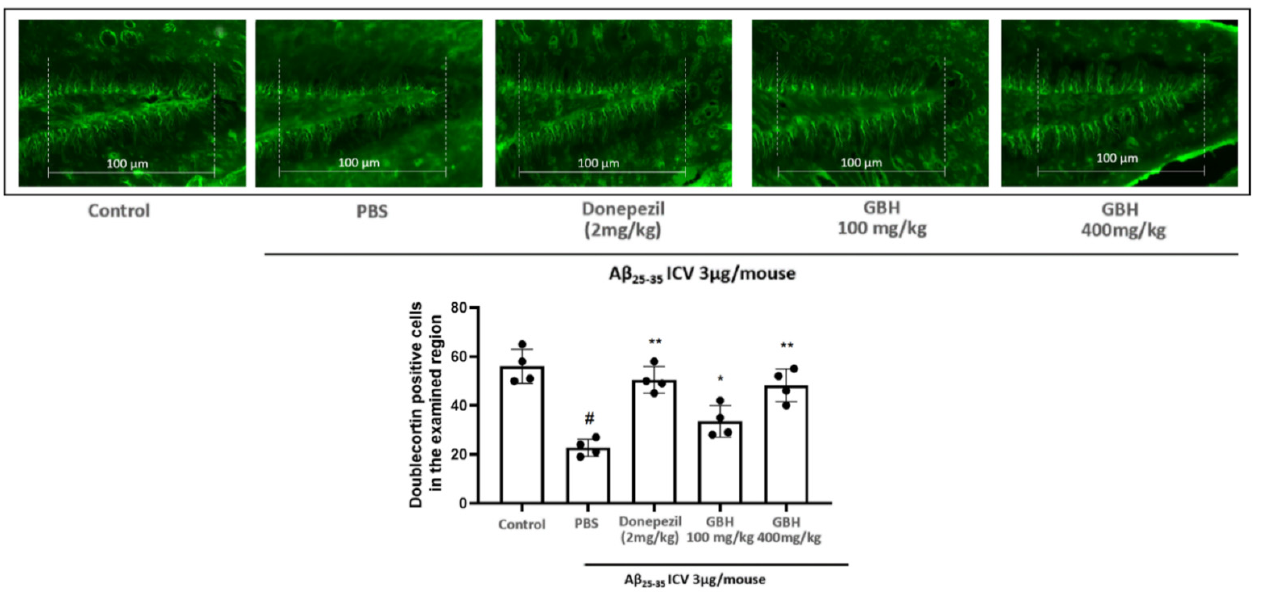
Figure 8. Effect of GBH to recover the impairment caused by A β 25–35 in animals. DCX Fluorescent immunohistochemical examination was conducted to clarify the effects of GBH (GBH) on A β 25–35 induced suppression of neurogenesis in the hippocampal dentate gyrus. Cells were counted within an identical area of 100 µm wide across all tissue sections, as shown in the images. Data are shown as mean ± SD in triplicate. #: p < 0.01 vs. control; *: p < 0.05 or **: p < 0.01 vs. A β 1–42 only-treated group.